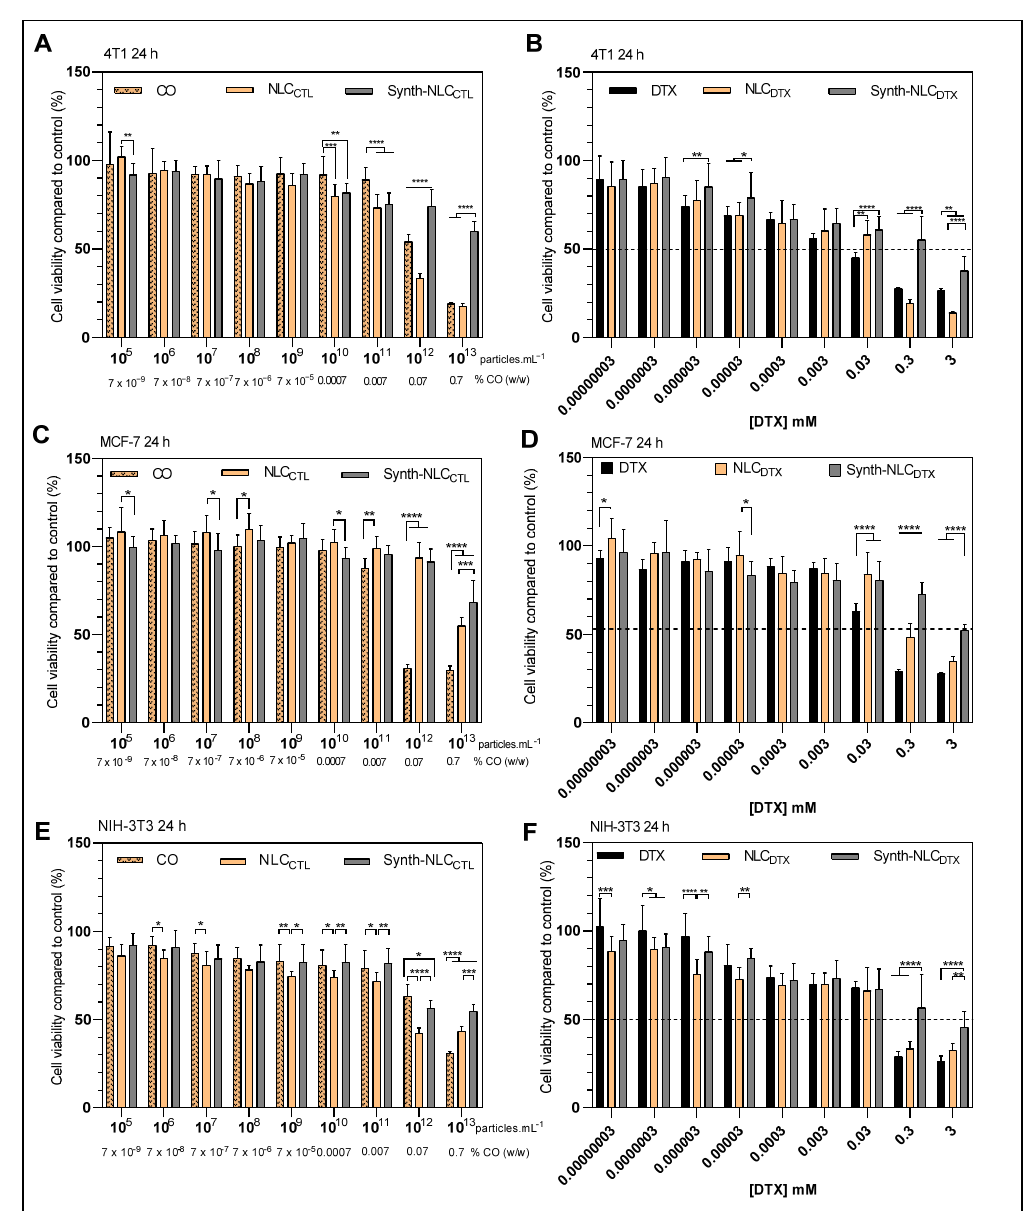
Figure 7. Cell viability (MTT assay) in 4T1 ( A , B ), MCF-7 ( C , D ) and NIH-3T3 ( E , F ) cells treated for 24 h with control samples: CO, NLC CTL and synth-NLC CTL , ( A , C , E ) and docetaxel-containing samples: free (DTX) or encapsulated in the optimized (NLC DTX ) or synthetic (Synth-NLC DTX ) nanoparticles ( B , D , F ). Results expressed as the mean ± SD (n = 3). Statistical analysis by two-way ANOVA plus Tukey–Kramer post hoc. * p < 0.05; ** p < 0.01; *** p < 0.001, **** p < 0.0001.